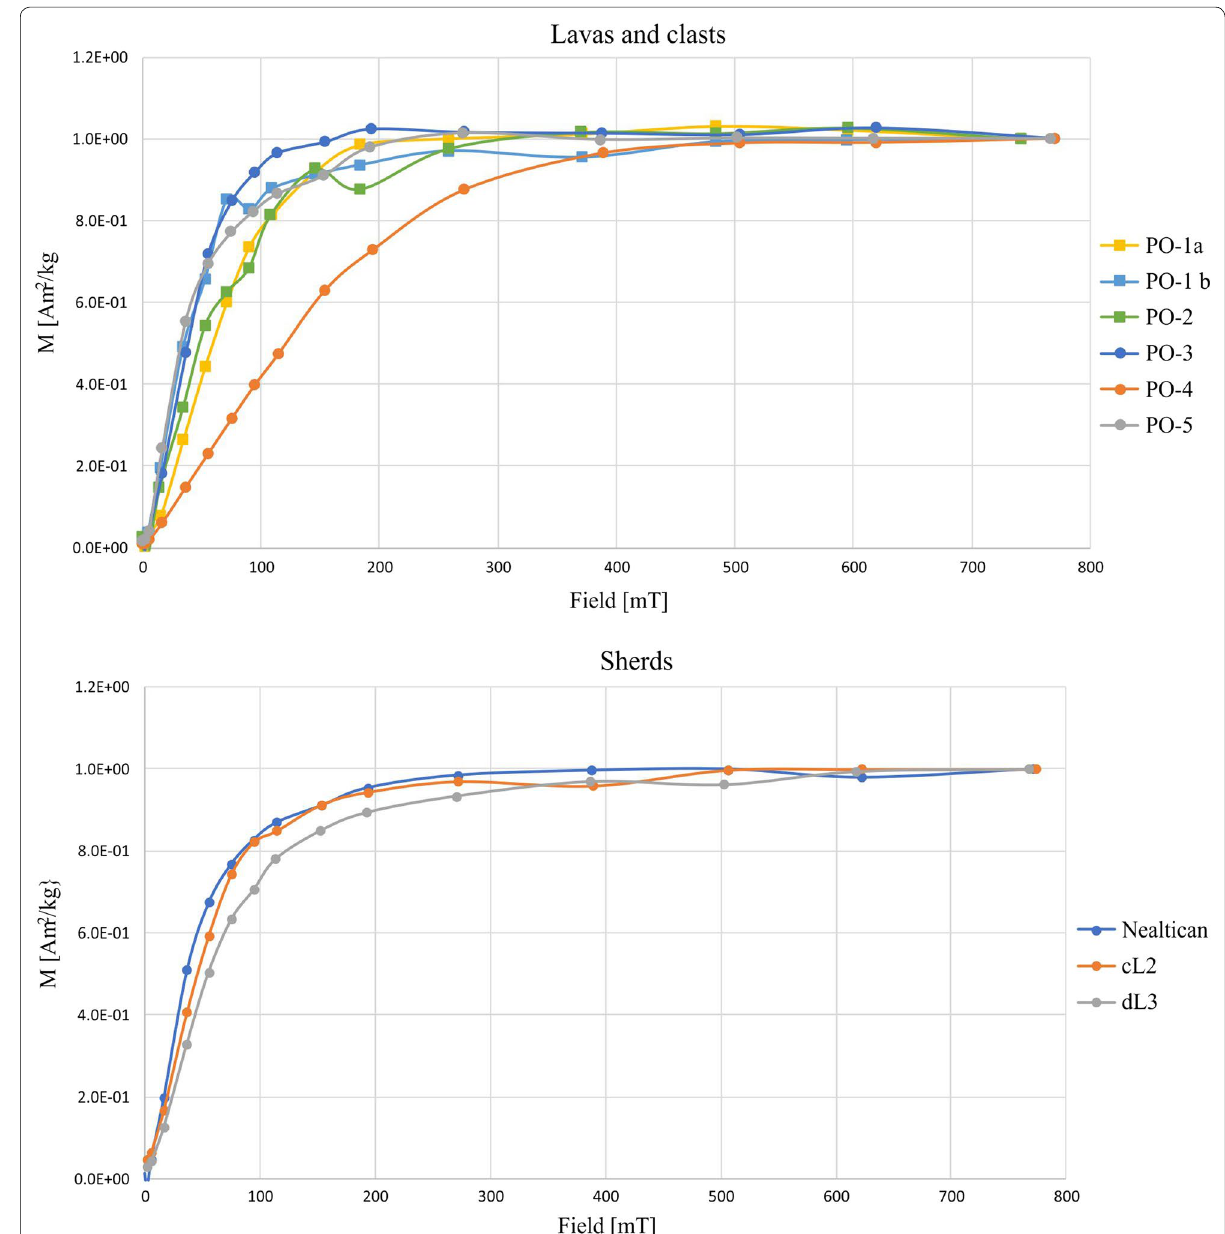
Fig. 7 Representative examples of isothermal remanent magnetization (IRM) acquisition curves for the three lava flows and scoria clast sampled (upper plots) and three ceramic fragments (lower